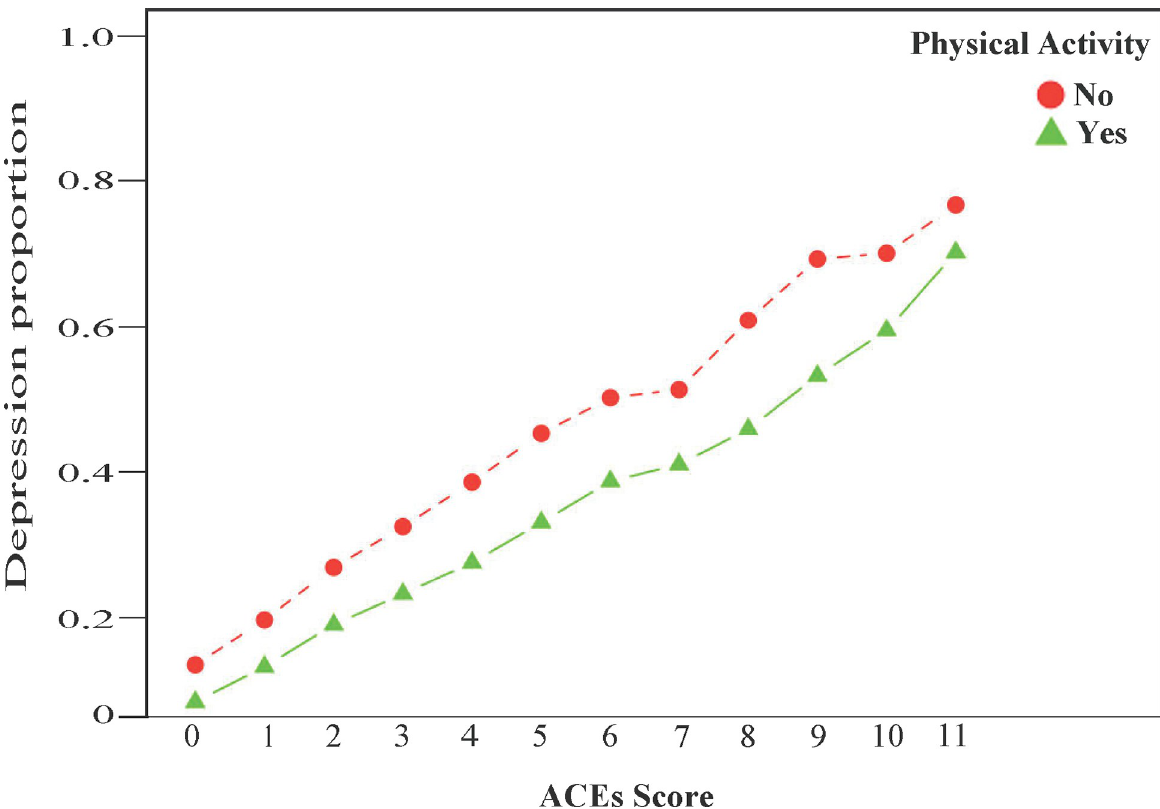
Fig 1. Interaction plot demonstrating physical activity attenuating the relationship between ACEs and depression among U.S. adults (n = 117,204). a Model displayed in figure adjusted for age, sex, race/ethnicity, and